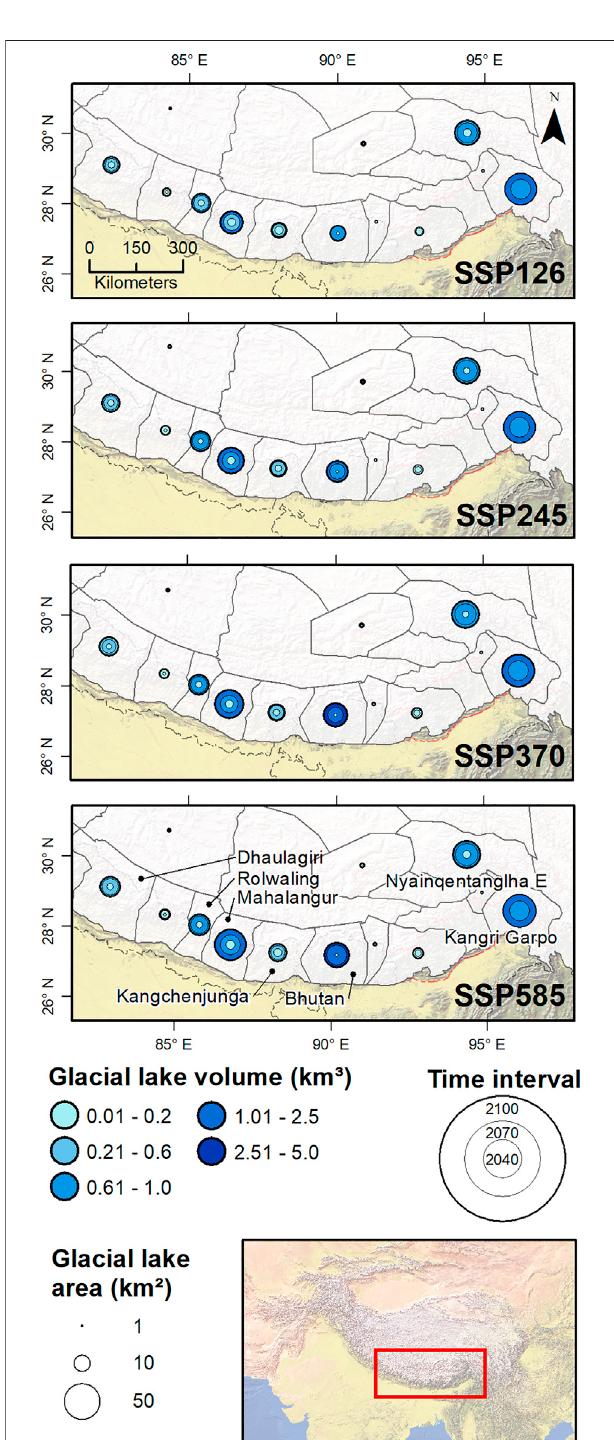
FIGURE 6 | Glacial lake formation under four SSP scenarios in the southwestern part of HMA. The three timesteps (2040, 2070, and 2100) indicatingthedevelopmentthroughoutthe21st centuryareindicatedbythree overlying circles, and with circle size and blue color scale, lake size and lake volume are